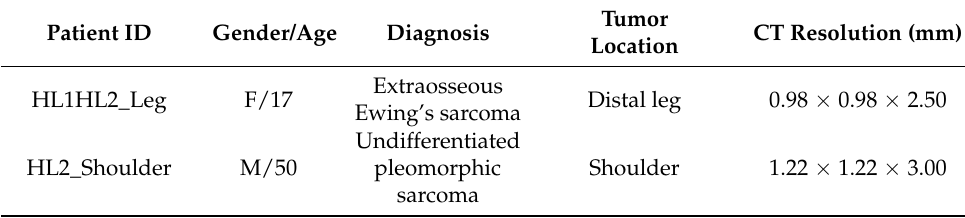
Table 1. Clinical description and CT scan resolution for each patient involved in the study.